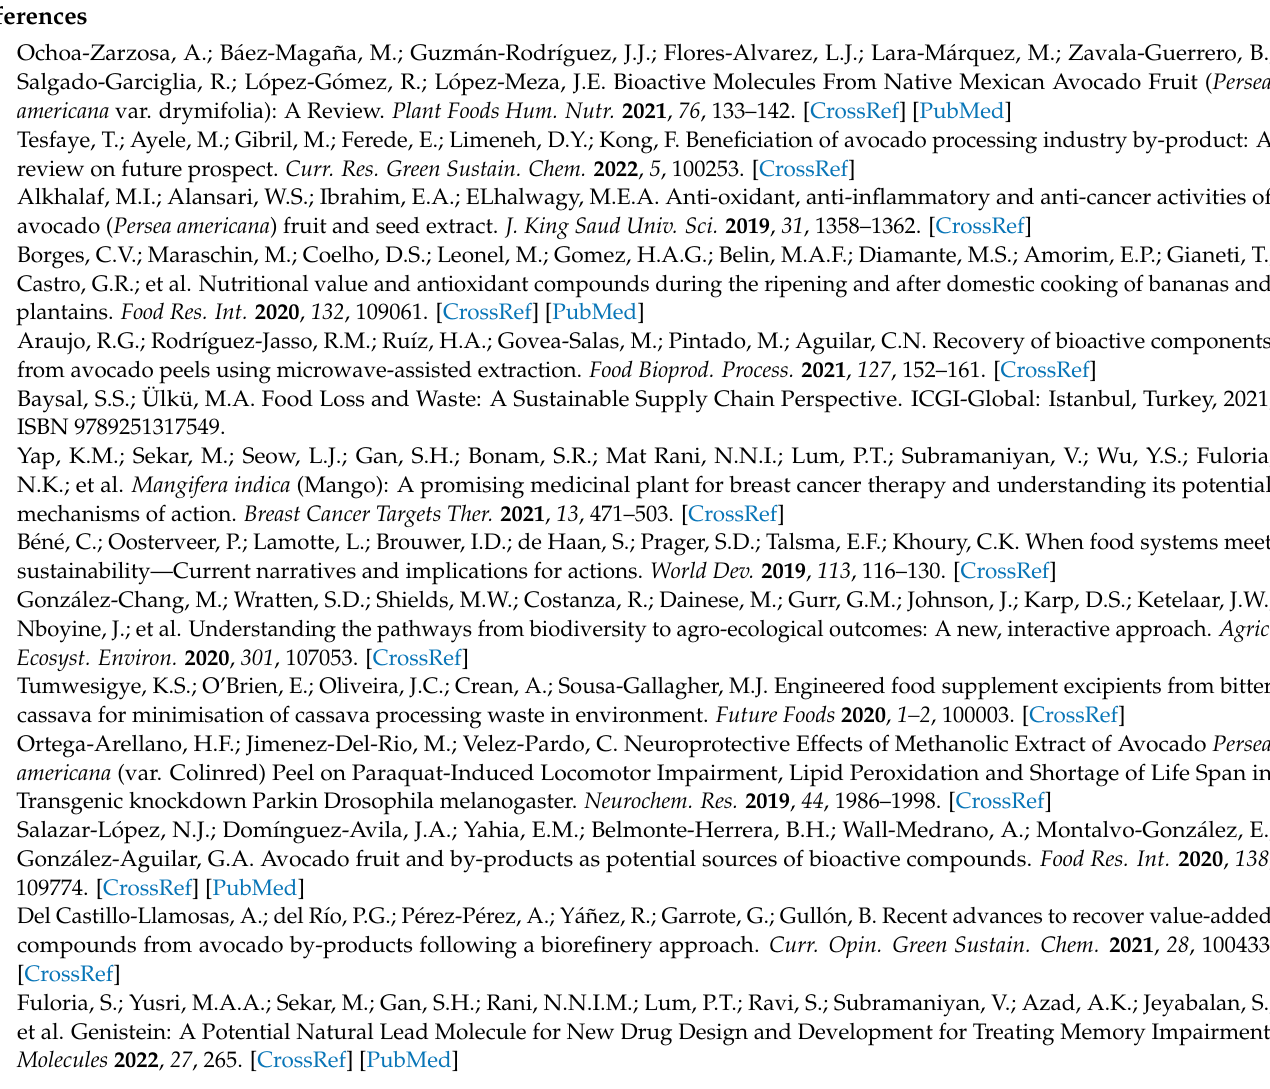
Figure S46: Luteolin-7-O-(2 (cid:48)(cid:48) -O-pentosyl)-hexoside PS( − )MS fragmentation and chemical structure, Figure S47: Catechin diglucopyranoside PS( − )MS fragmentation and chemical structure, Figure